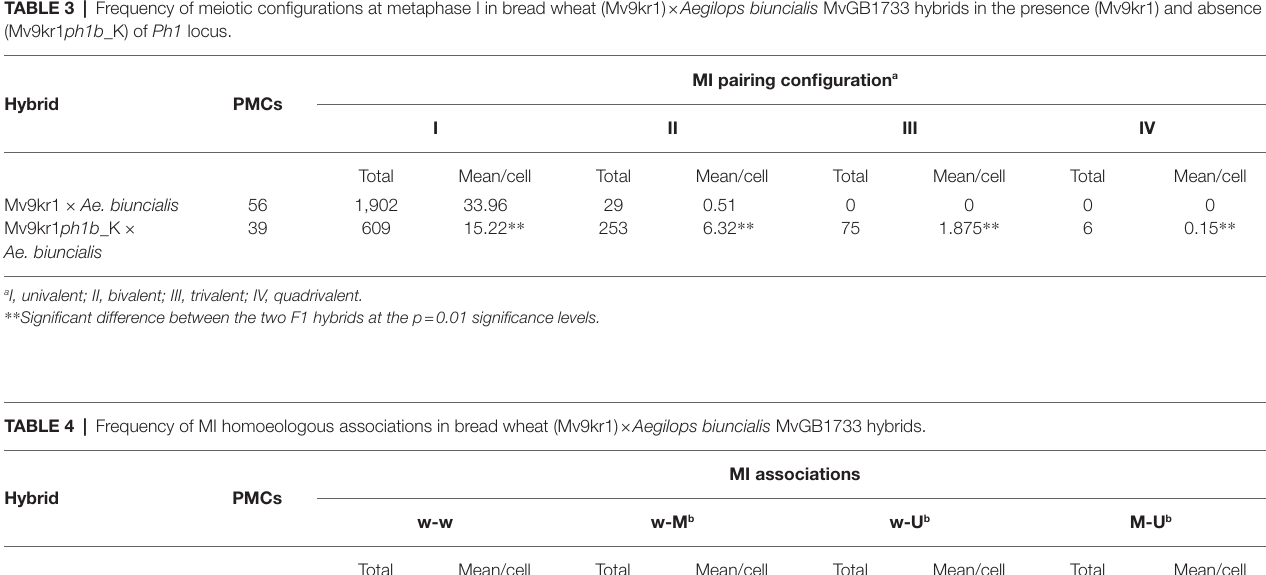
TABLE 3 | Frequency of meiotic configurations at metaphase I in bread wheat (Mv9kr1) × Aegilops biuncialis MvGB1733 hybrids in the presence (Mv9kr1) and absence (Mv9kr1 ph1b _K) of Ph1 locus.